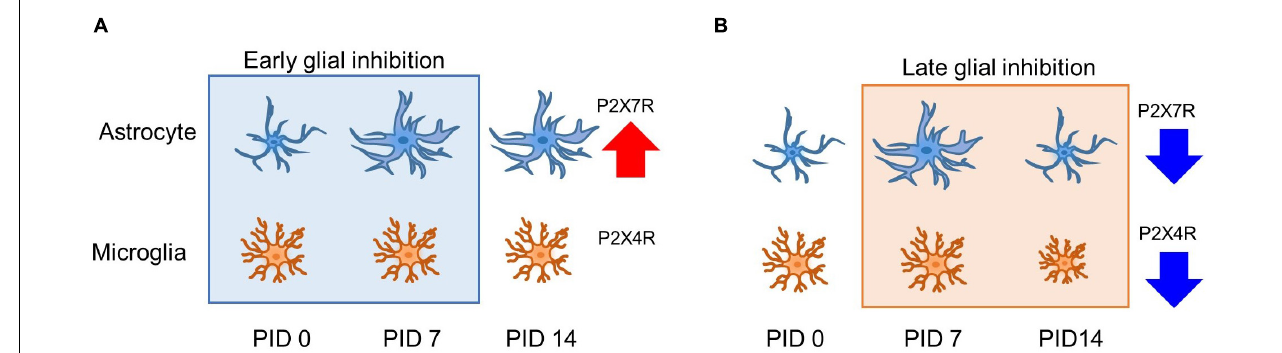
FIGURE 8 | Glia and purinergic receptor changes after early and late inhibition of chronic pain. (A) Astrocyte and microglia change after early inhibition. Astrocytes show morphological changes with related channel expression. (B) Glial cell changes in late inhibition. On PID 7, microglia did not significantly change morphological shape and molecular expression after nerve injury. However, increased astrocyte shape and expression were observed on PID 7 after late inhibition, and both glial cells showed decreased expression after late inhibition on PID 14. Early and late inhibition showed different effects on the astrocytes and microglia via P2X4R and P2X7R. Red and the blue arrow indicates increased and reduced